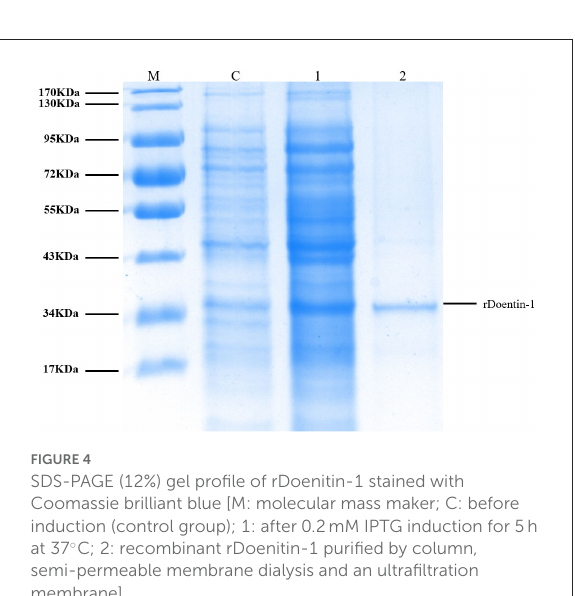
FIGURE4 SDS-PAGE (12%) gel profile of rDoenitin-1 stained with Coomassie brilliant blue [M: molecular mass maker; C: before induction (control group); 1: after 0.2mM IPTG induction for 5h at 37 ◦ C; 2: recombinant rDoenitin-1 purified by column, semi-permeable membrane dialysis and an ultrafiltration